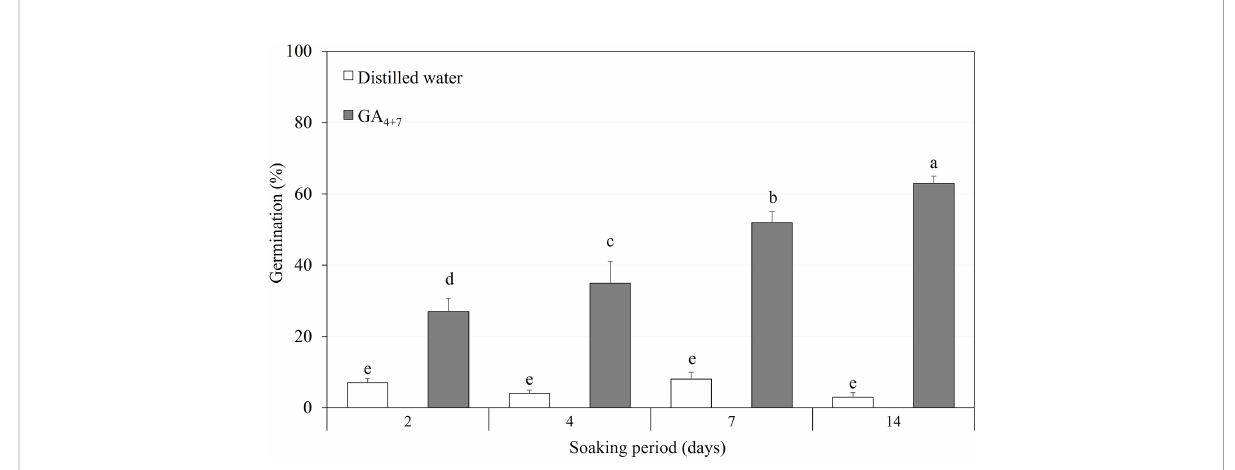
FIGURE 7 The comparison of overall percent germination of Amsonia elliptica seeds soaked either in distilled water or in 500 mg/L GA 4+7 for 2 to 14 days. Bars indicate standard errors ( n = 4). Different lowercase letters indicate a signi fi cant difference tested by Duncan ’ s multiple range test ( P <